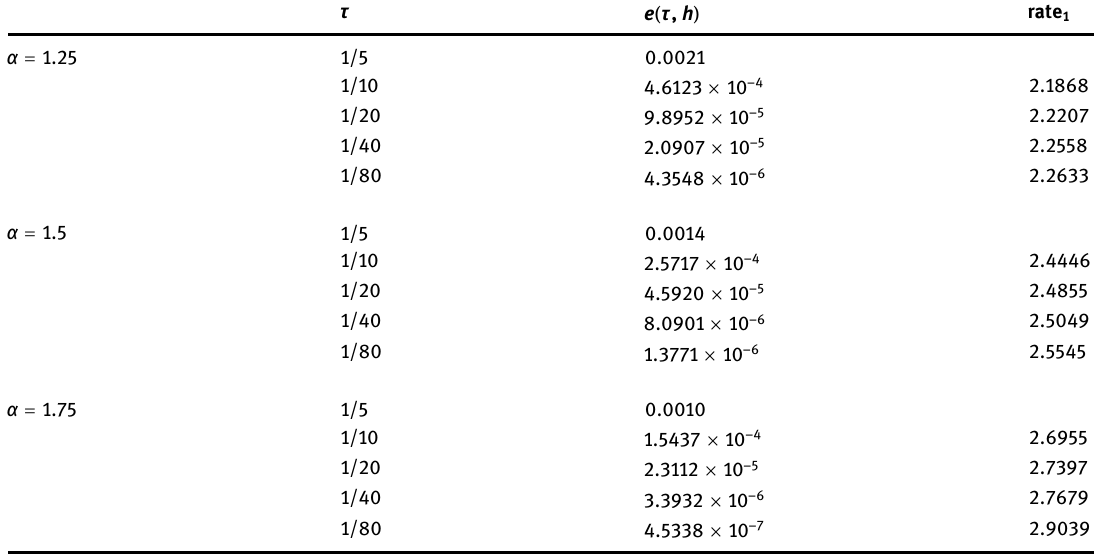
Table 4: Maximum norm errors and temporal convergence orders of the proposed scheme when = / h 1 20 for Example 2